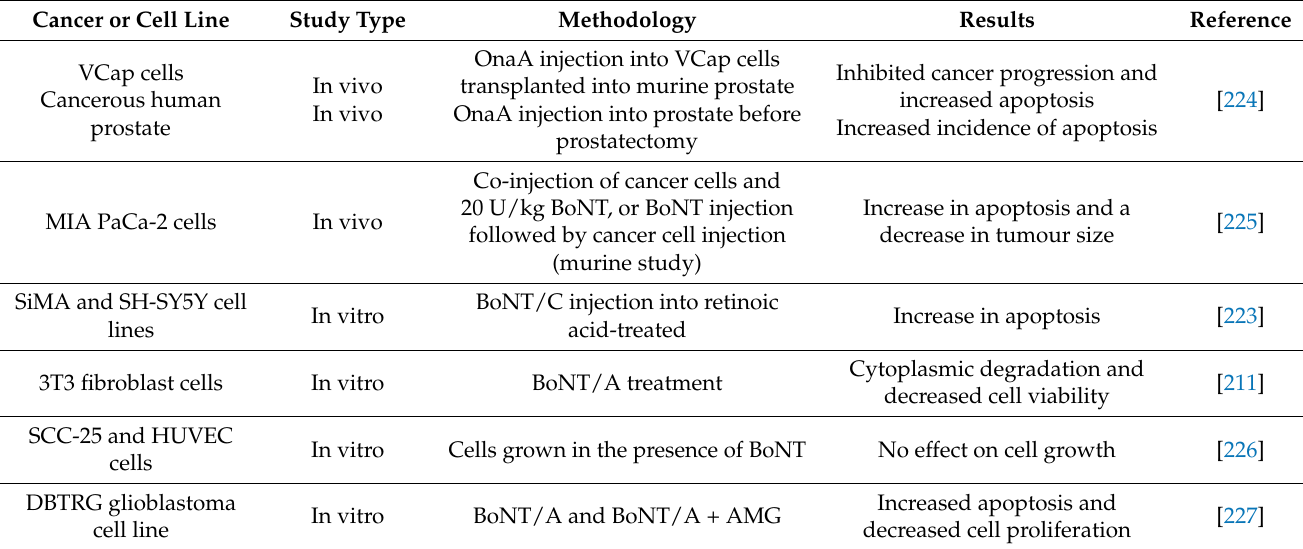
Table 2. Studies using BoNT as an anti-cancer